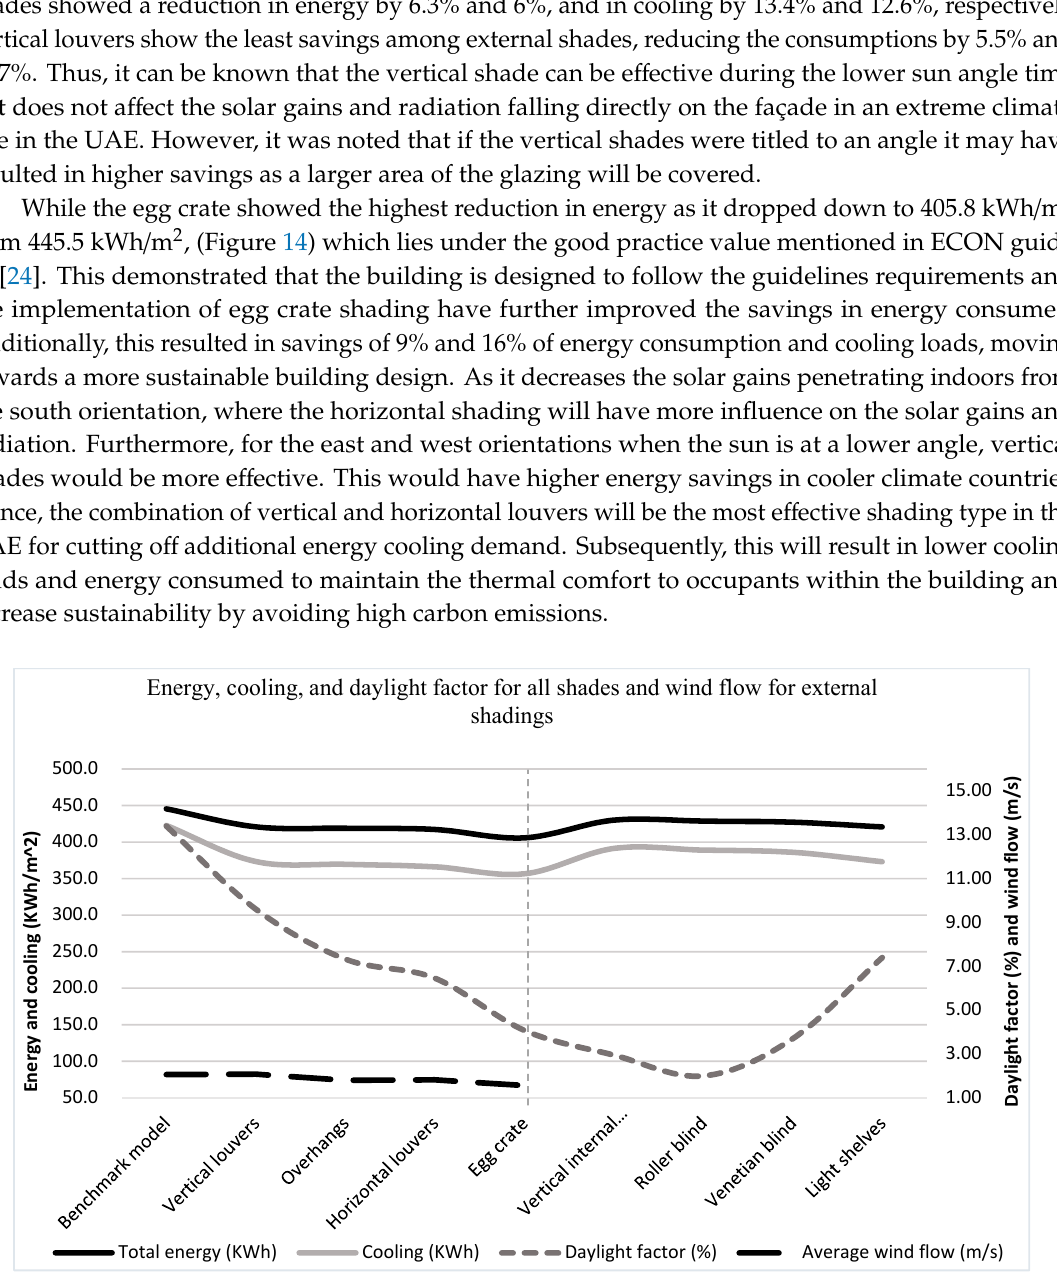
Figure 14. Outcomes of external and internal shade for energy consumption, cooling loads, daylight factor, and wind flow for external shades.